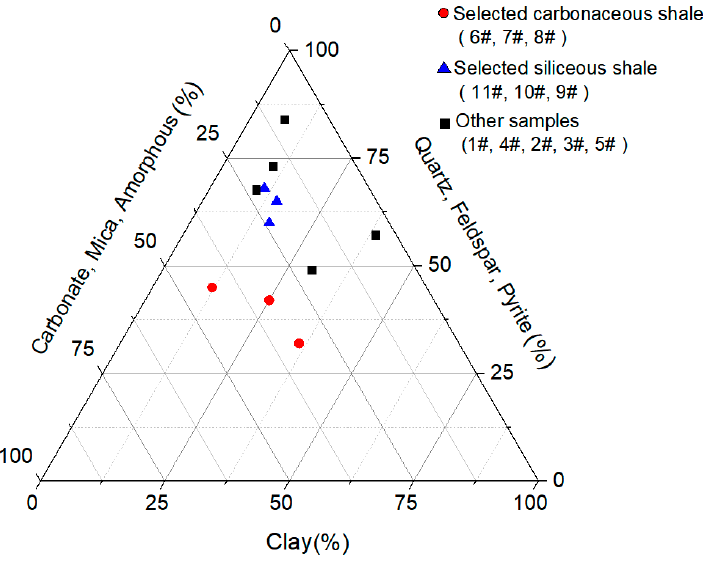
Figure 10. Ternary plot of the mineral content of Niutitang Formation shale in northwestern Hunan.